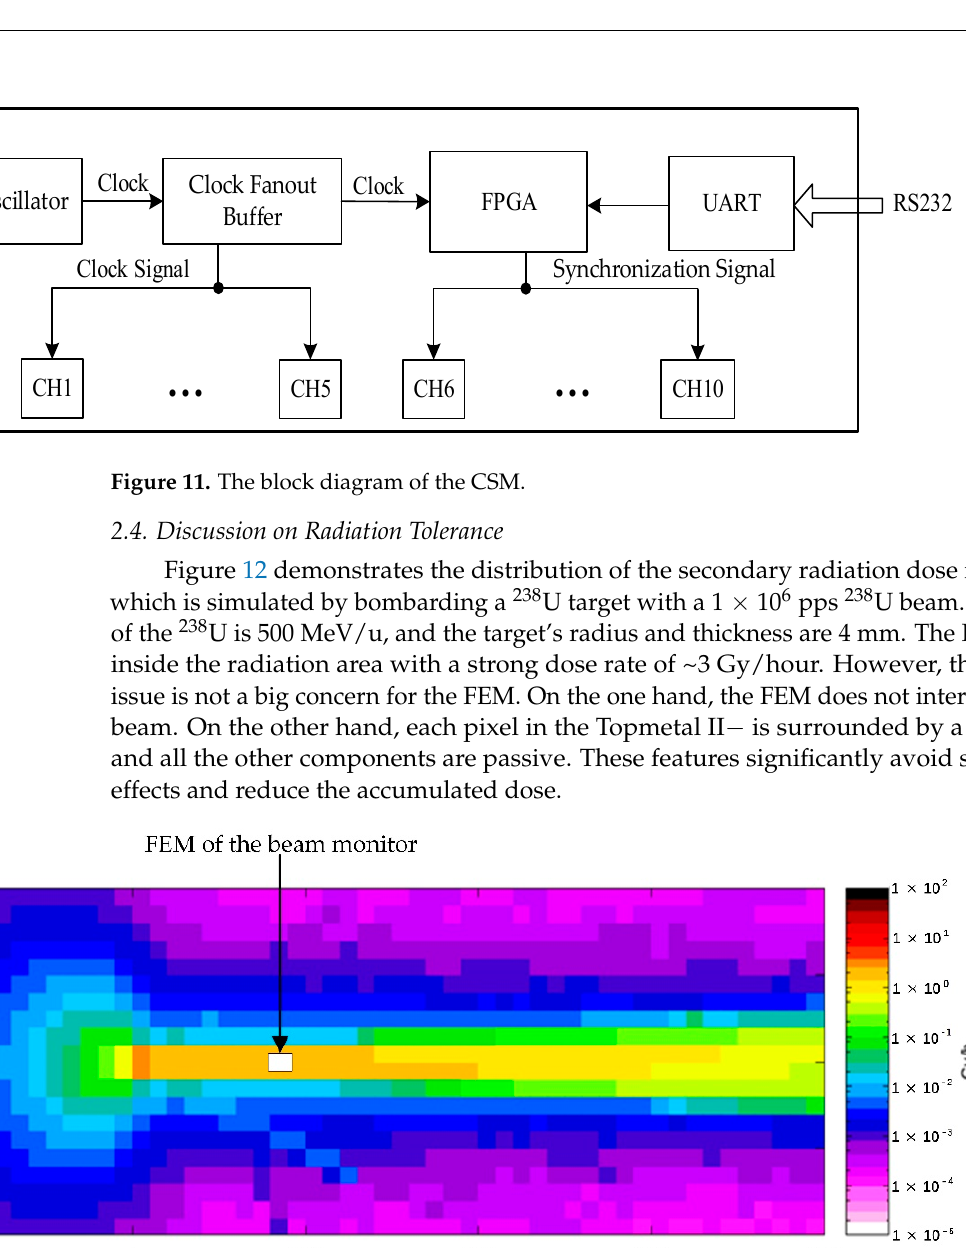
8 of 13 Figure 10. The diagram of the FPGA design. 2.3. Clock Synchronization Module The CSM delivers synchronous clocks and synchronization signals to the RCMs. This scheme is essential to ensure the time synchronization of the data collected from all the FEMs to reconstruct the ion track. Figure 11 shows the block diagram of the CSM, which mainly consists of a 200 MHz crystal oscillator, the clock fanout buffer, the Altera EP3C16F484C8N [20] FPGA, and the UART interface. The clock fanout buffer is IDT8SLVD1208I [21] from Renesas Electronics Corporation can fan out eight channels of